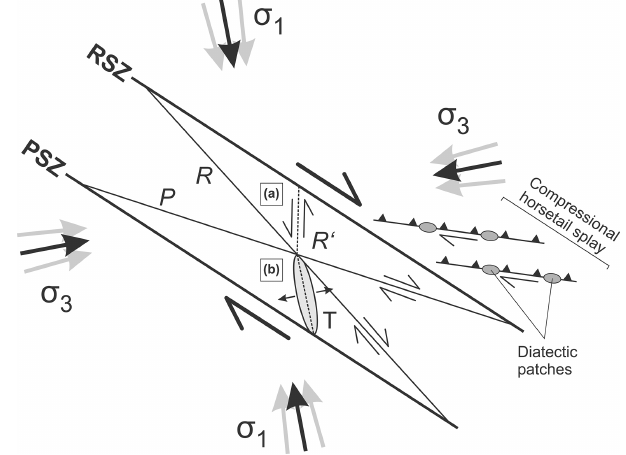
Figure 11. Interpreted tectonic framework in domain B based on the orientations of detected topographic lineaments (modified and extended after Zeitlhöfler, 2007). NW–SE- to NNW–SSE-oriented “Riedel shears” (R) and WNW–ESE-oriented P shears form as syn- thetic strike-slip faults with a right-lateral sense of motion. Ca. NNW–SSE- to N–S-striking lineaments either represent (a) anti- thetic strike-slip faults with a left-lateral sense of motion (R’) or (b) extensional fractures ( T ), which are oriented subparallel to the maximum principal stress ( σ 1). Fault zones: PSZ – Pfahl Shear Zone; RSZ – Runding Shear